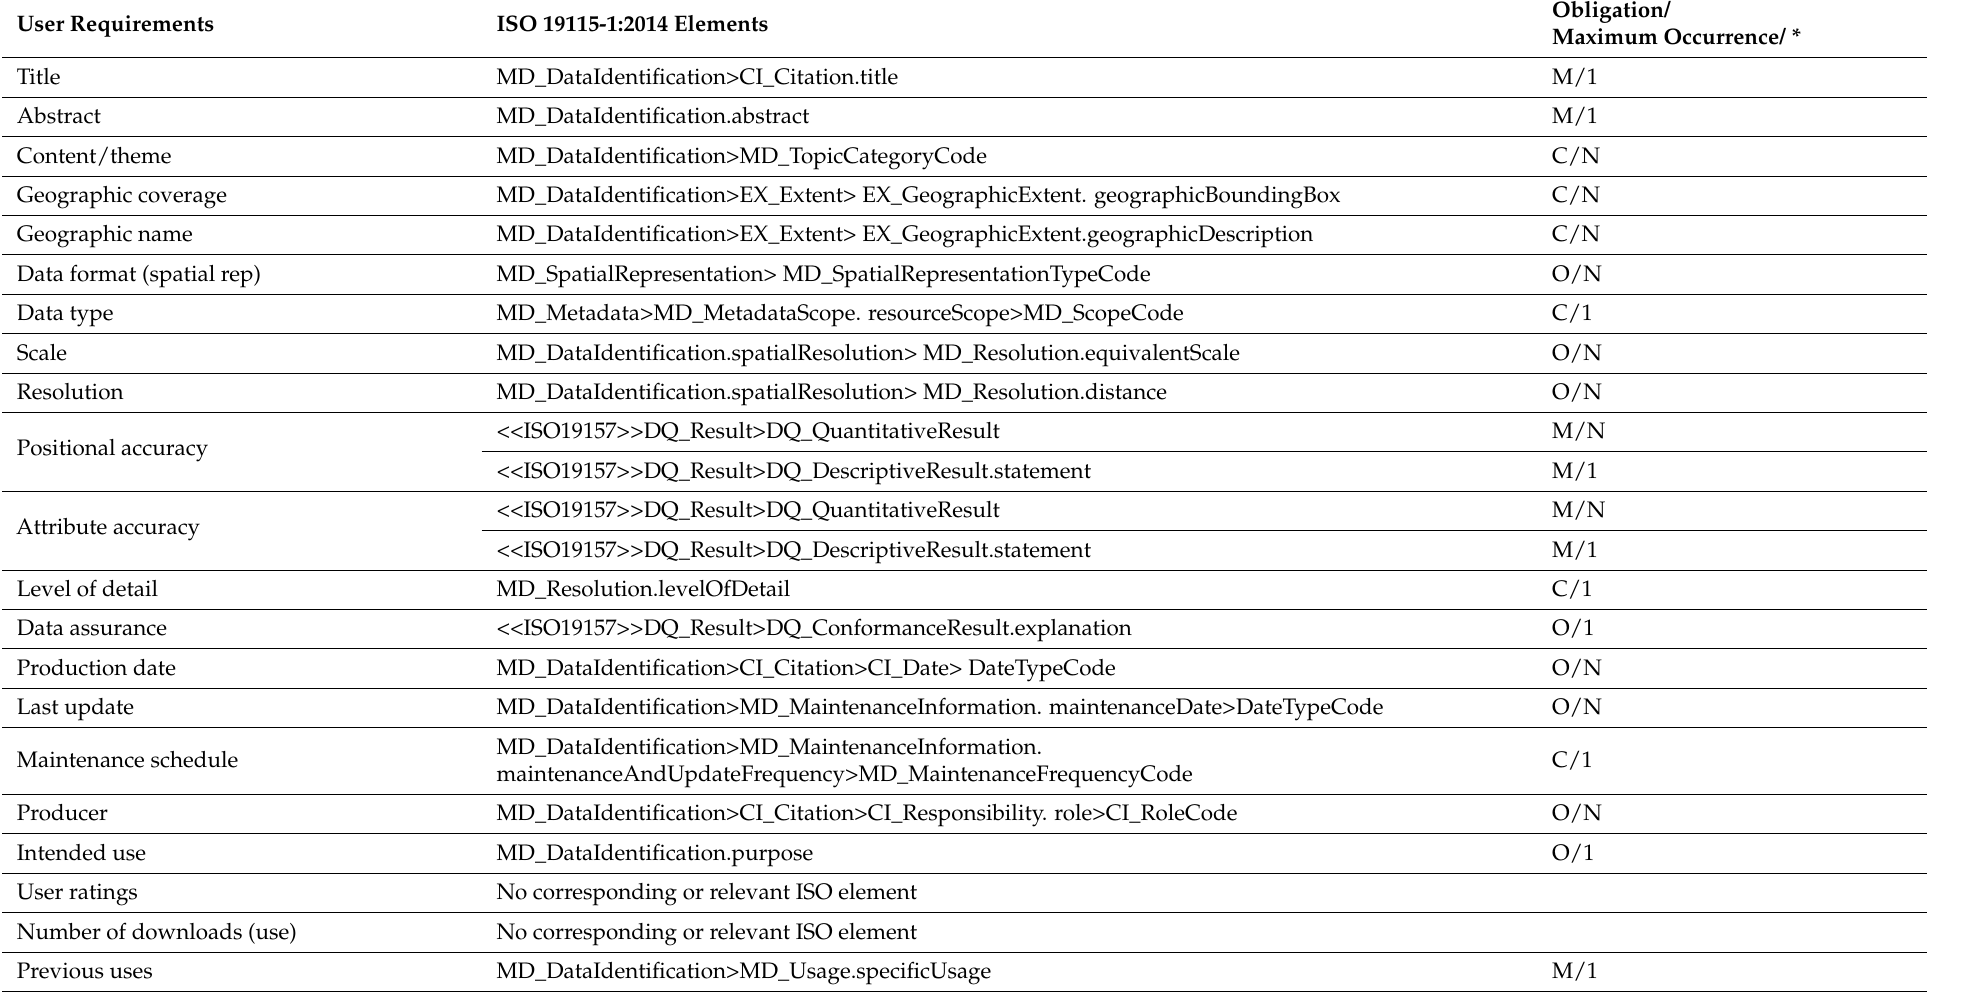
Table 16. Mapping user requirements to ISO 19115-1:2014